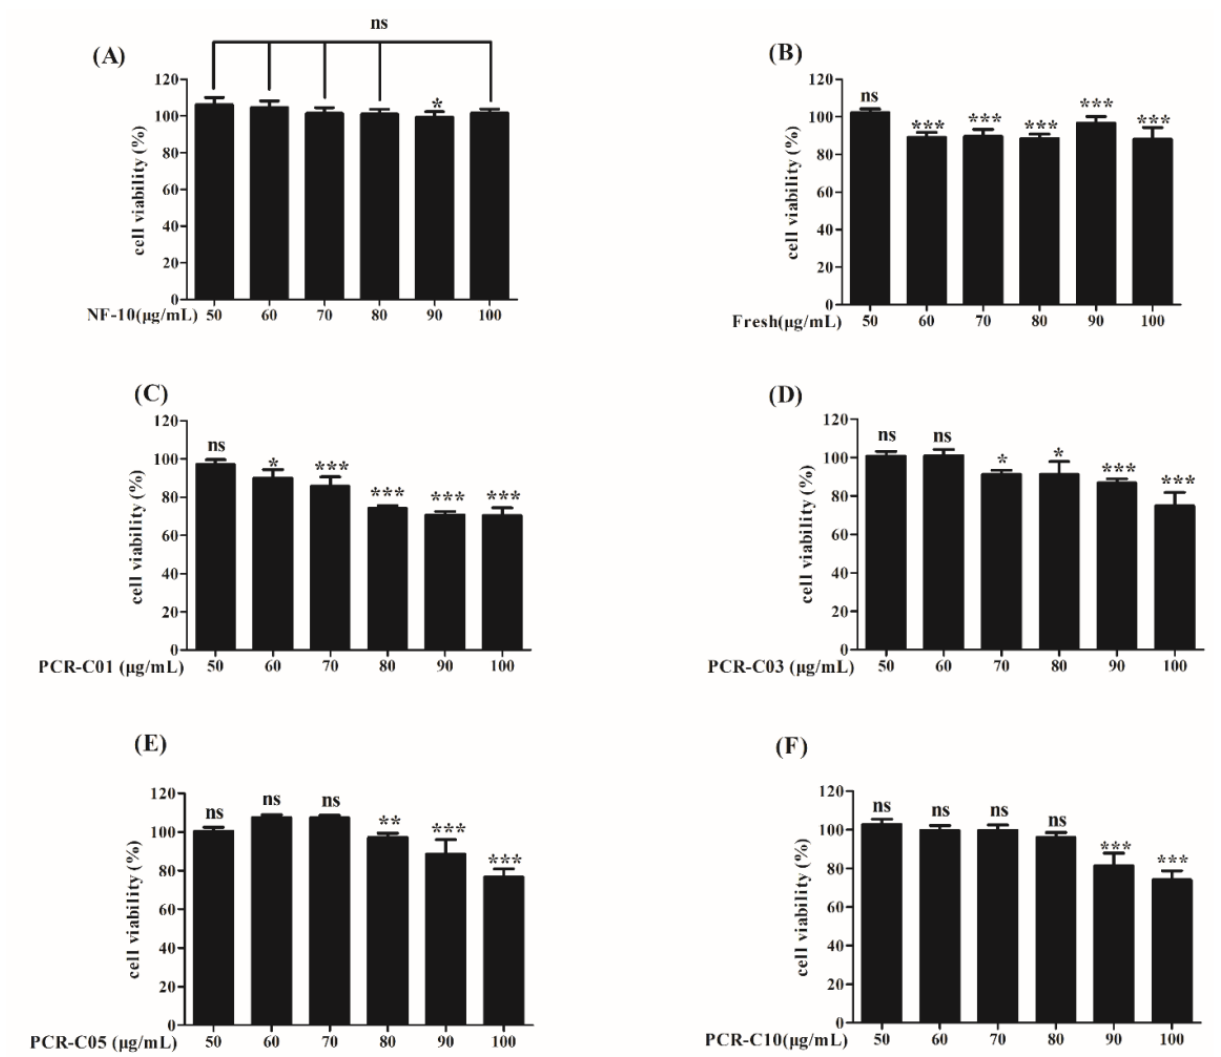
Figure 4. The cytotoxicity of NF-10 ( A ), Fresh ( B ), PCR-C01 ( C ), PCR-C03 ( D ), PCR-C05 ( E ), PCR-C10 ( F ) in HepG2 cells. HepG2 cells were treated with various concentrations of samples (50–100 µ g/mL) for 24 h, and then cell viability was analyzed by MTT assays. Results are presented as mean ± SD, n = 6. Statistical comparisons were made using the Student’s t -test. ns means no significant difference. * p < 0.05, ** p < 0.01, *** p < 0.001 vs. control